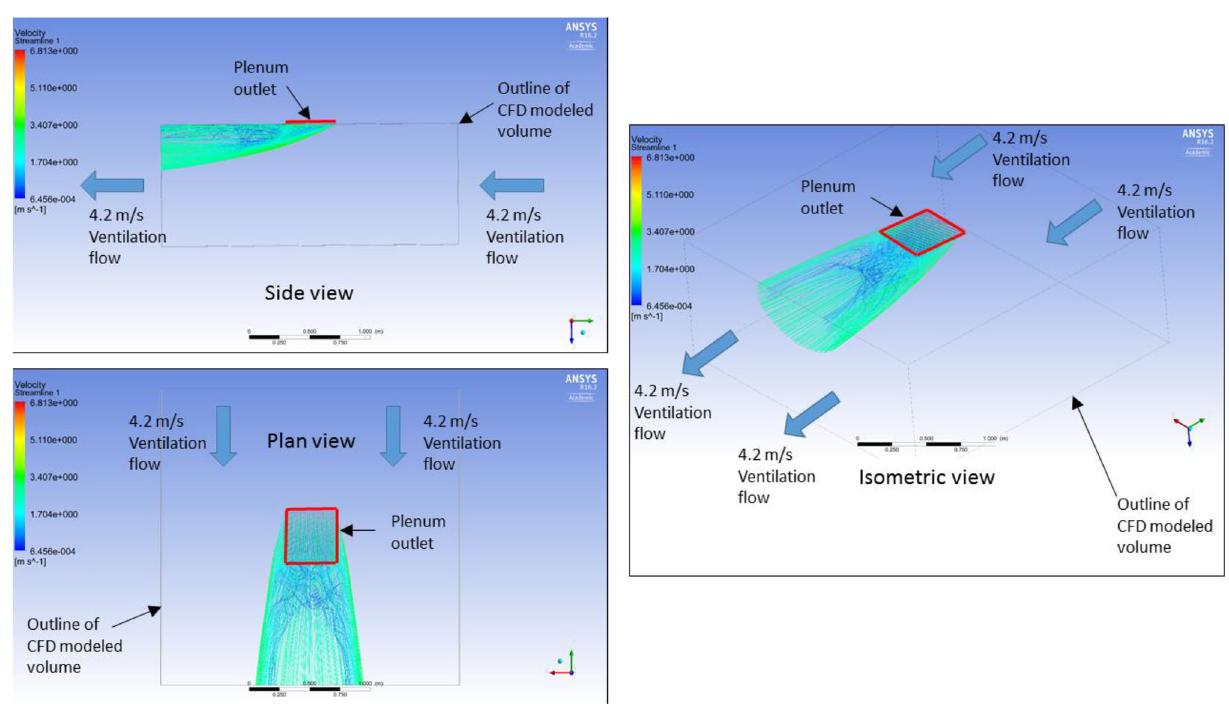
Fig. 7 CFD simulation results showing airflow streams from shuttle car CAC plenum in 4.2 m/s ventilation airflow (Marshall